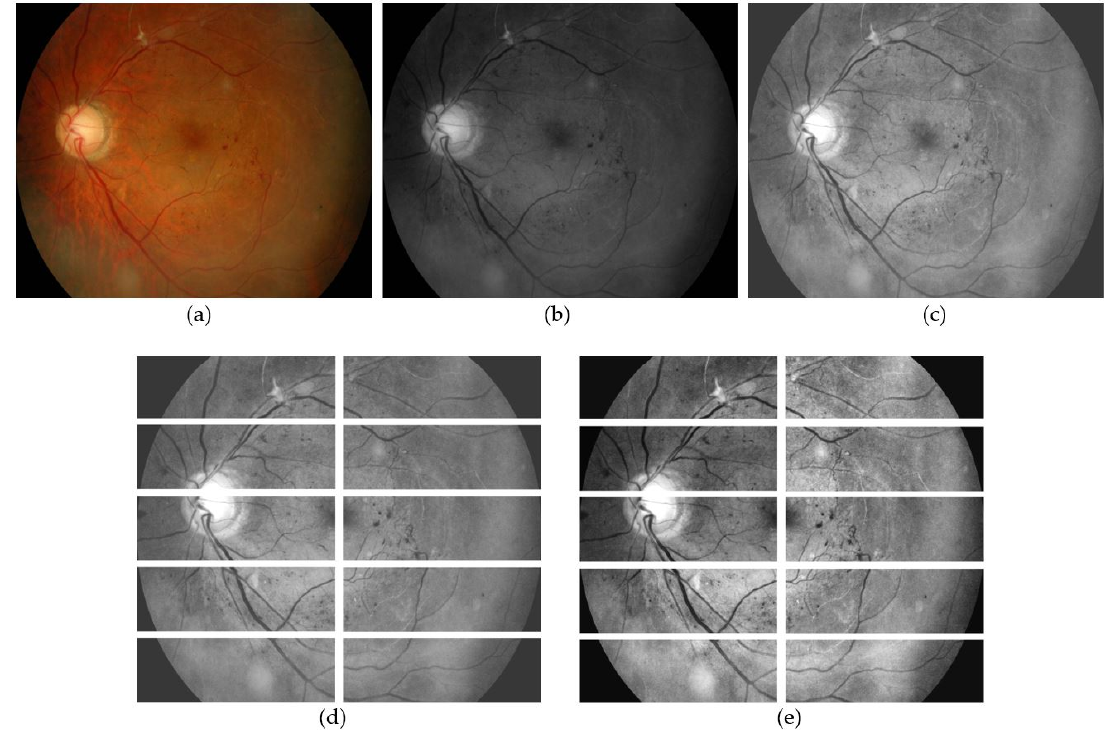
Figure 4. Image pre-processing steps. ( a ) input fundus image; ( b ) green channel extraction; ( c ) CLAHE is applied to the image; ( d ) the image is cropped into ten small patches; ( e ) image normalization is applied to the patches. Each ground truth image is also subjected to the same cropping and divided into 10 smaller patches. During training, the network learns to identify each pixel as Neo or NotNeo based on its ground truth. The process of cropping ground truth is depicted in Figure